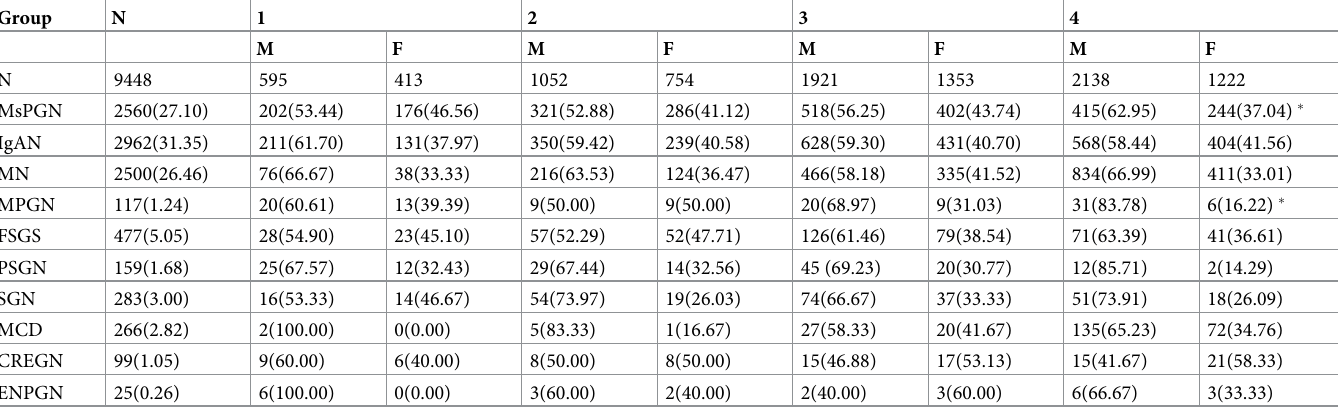
number of 9448 cases. In recent 5 years, it is the kidney disease study with the largest time span and single center sample size in China, following the 36-year kidney disease spectrum released by General Hospital of Nanjing Military Region [13]. It is the first one in Shaanxi province in the field of primary glomerular disease spectrum. Table 6. Comparison of pathological types of different genders in each group.